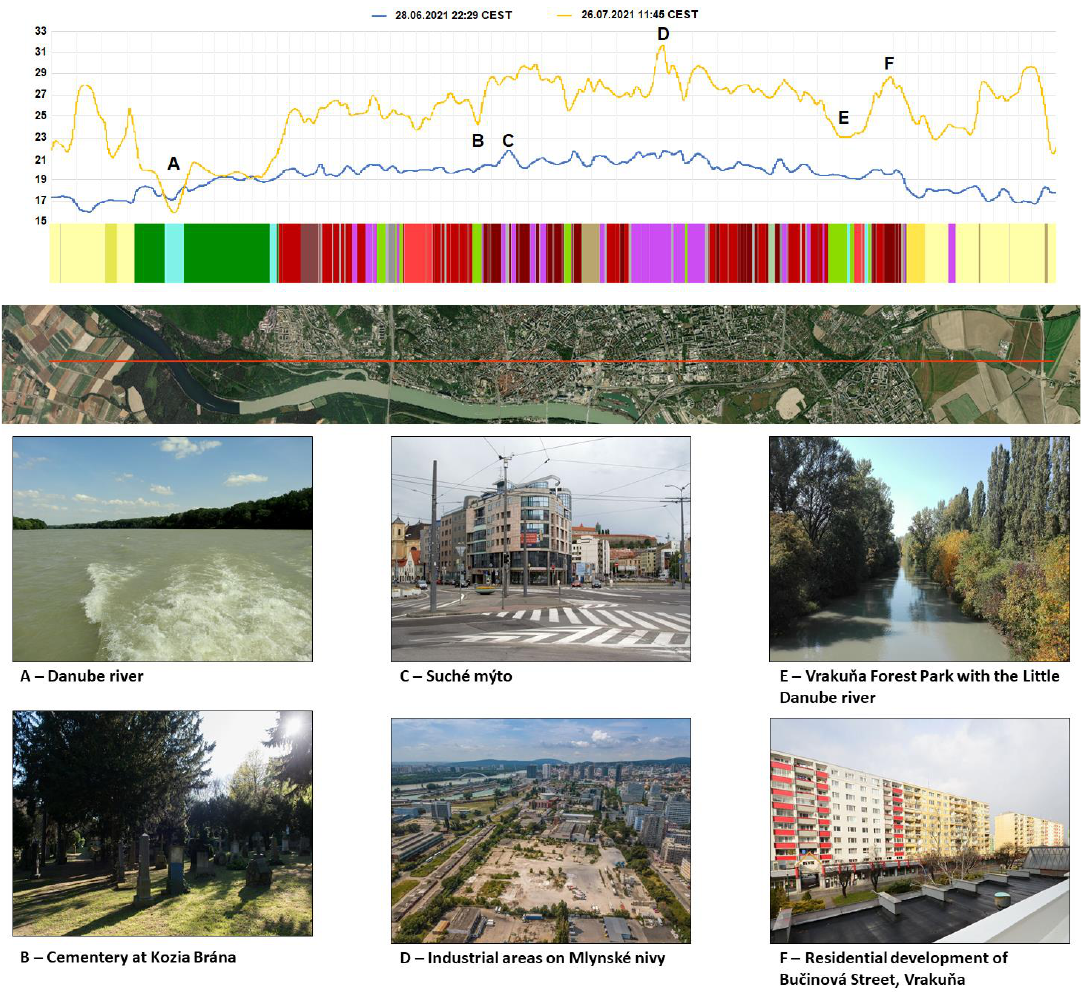
Figure 5. Profile section of Bratislava (20 km) divided by Urban Atlas category classes and respective day and night time temperatures of surface types. Subfigures ( A – F ) represent selected locations in the city.